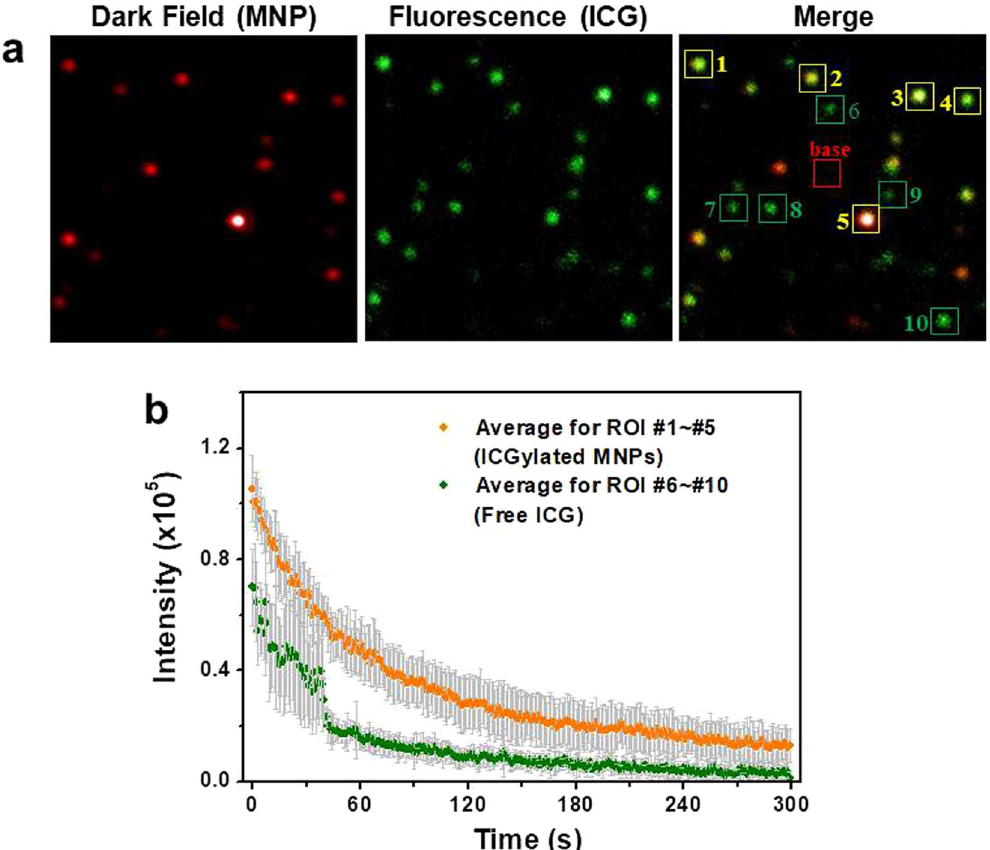
Figure 3. Enhanced photostability of ICG after ICGylation. ( a ) Dark-field (red), fluorescence (green), and merged images of ICGylated MNPs. MNPs are shown in the dark-field image; ICG is shown in the fluorescence image. In the merged image, the ICGylated MNPs appear yellow, whereas the free ICG molecules appear green. Yellow boxes (1–5) and green boxes (6–10) were selected as ROIs to measure the fluorescence signals for coated ICG and free (uncoated) ICG, respectively. ( b ) Averaged fluorescence intensities under continuous radiation (at 785 nm) for each ROI. Individual fluorescence intensities for each ROI are indicated in Supplementary Fig.